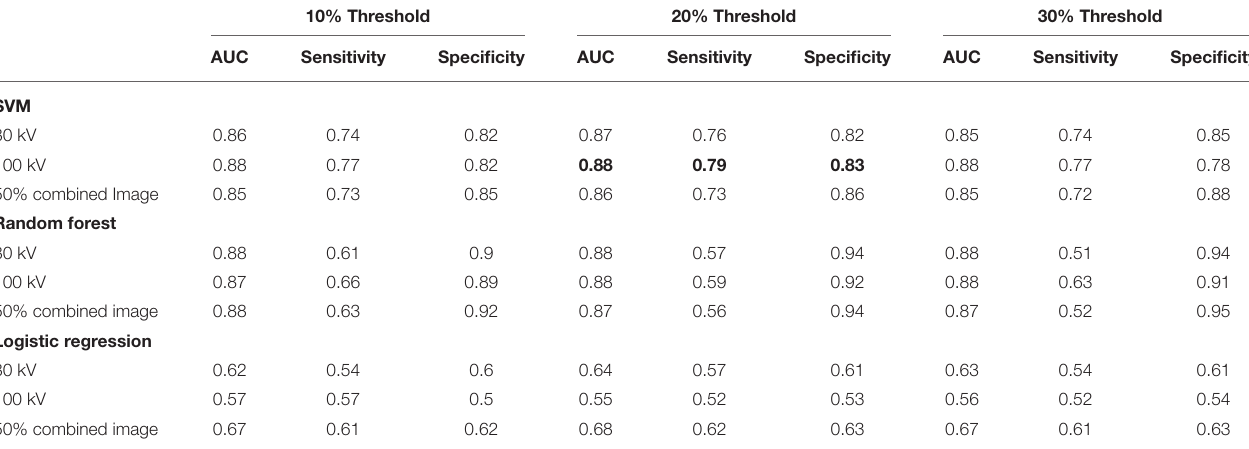
TABLE 1 | Area under ROC curve, sensitivity and specificity for the classifiers at all three energy levels and three scar